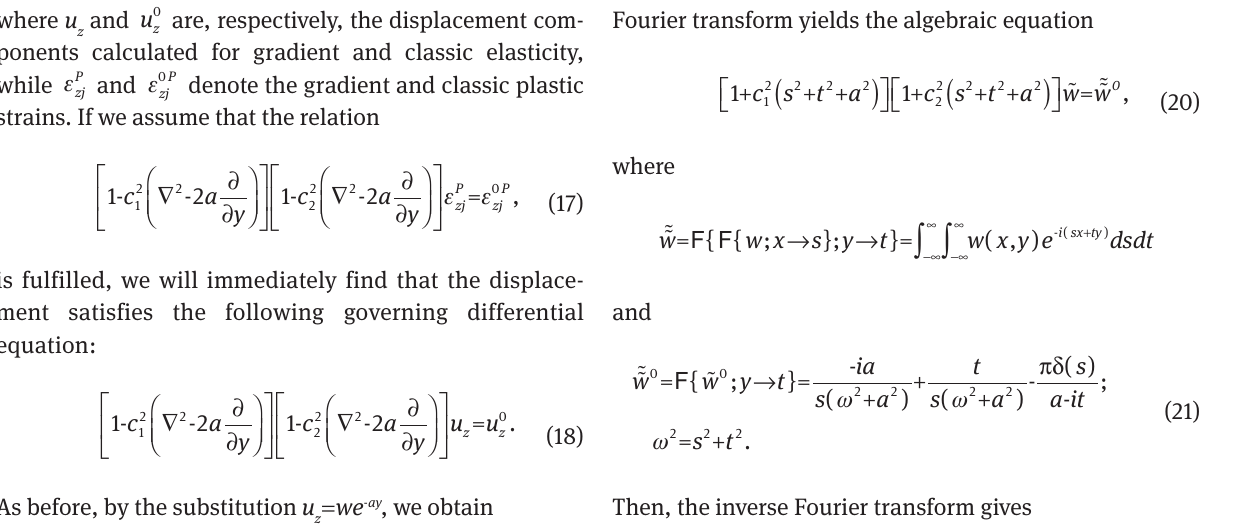
Figure 3 The profile of the plastic strain (0, ) P zy y ε of a screw dislocation in an FGM within the second strain gradient elasticity, (A) when a = 0.5 and c and a = 0, 0.5, and 1. The strain values are given in units of μ (4 π c 1 and (B) ε , of a screw zx zy = 0.5 within the second / c 2 1